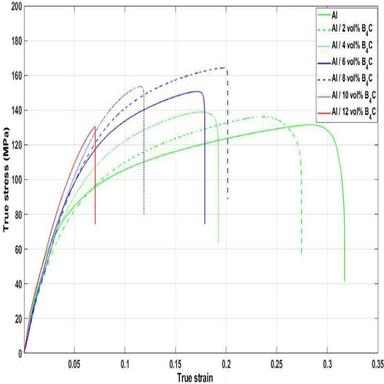
Tensile true stress true strain curves of Al/B4C composite with different B4C content.